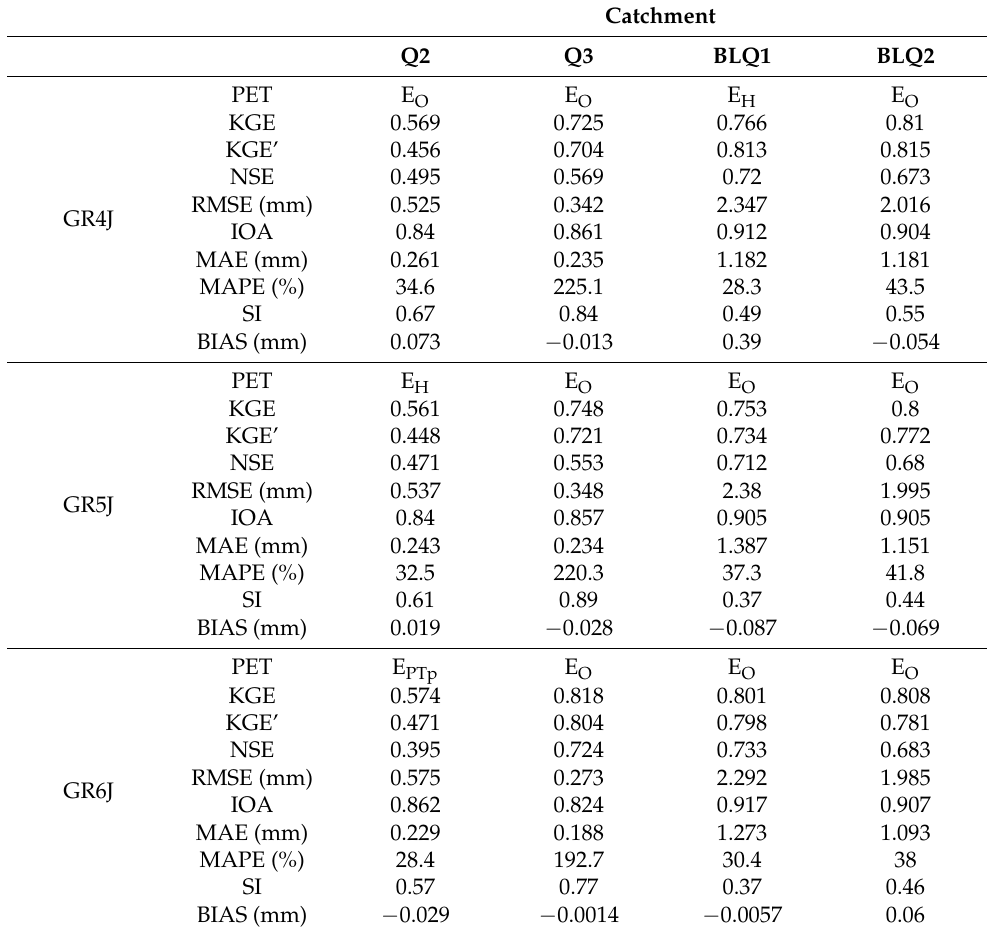
Table 4. Best evapotranspiration models (PET) that maximize hydrological model performance for the calibration